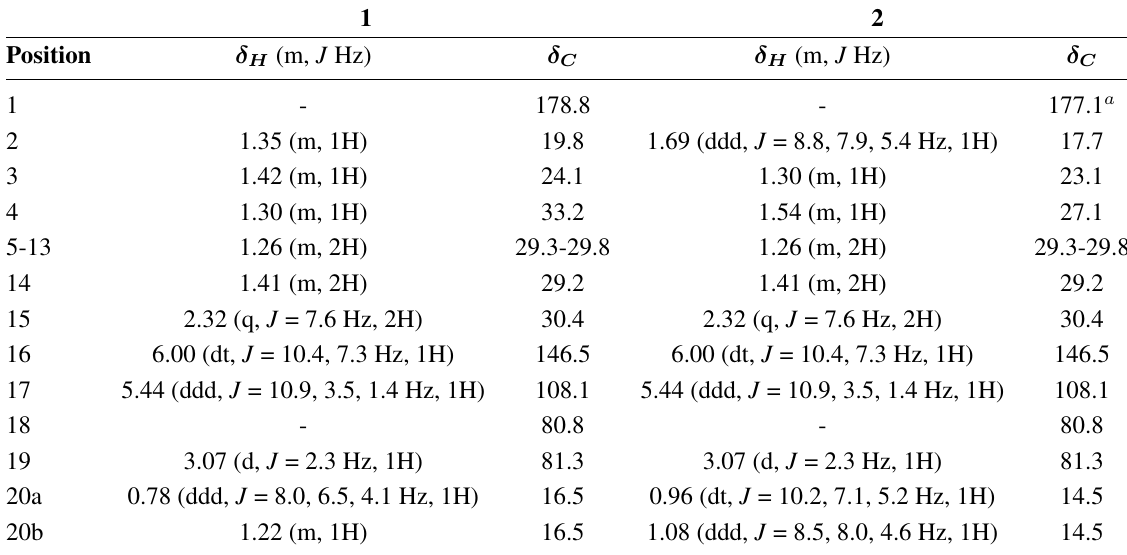
, (cid:14) in ppm) of 1 and 2 3